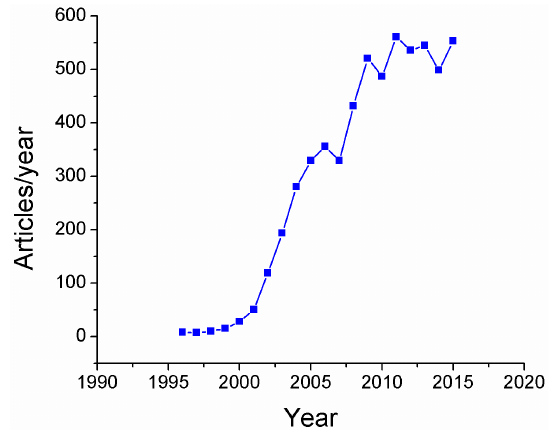
Figure 1. Number of published documents (article, conference paper, review or book chapter) with